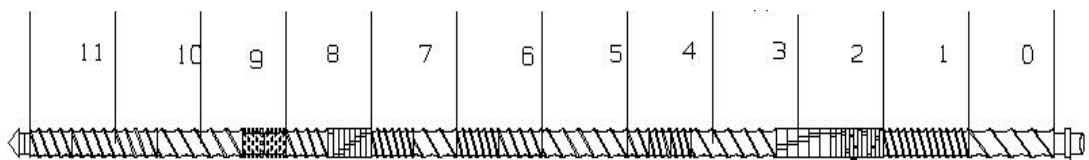
Figure 15. Screw configuration used in extrusion.